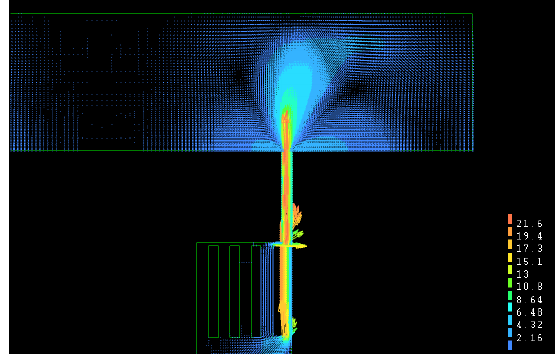
Fig. 7. Outcoming airflow in the plan when the central and side electrodes located at the same heights